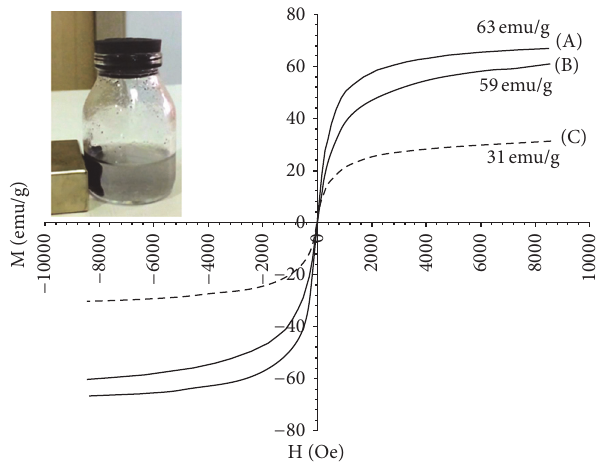
Figure 5: VSM of bare Fe 3 O 4 nanoparticles, MNPs-NH 2 , and PGMA-MAn/ABSAc@Fe 3 O 4